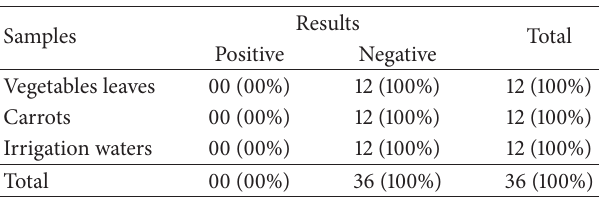
Table 6: Summary of the results of the samples of gardens 4, 5, and 6 using NPK as